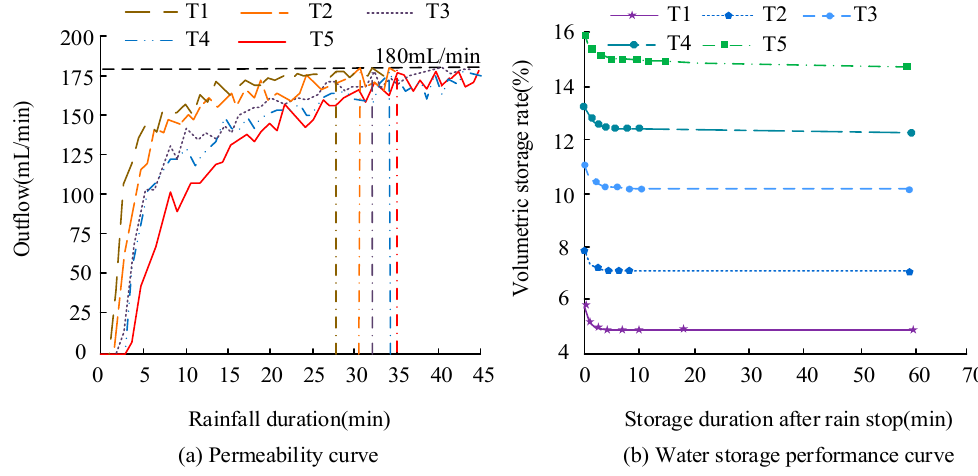
Figure 7. Seepage and storage performance curve of recycled brick aggregate with different volume content.